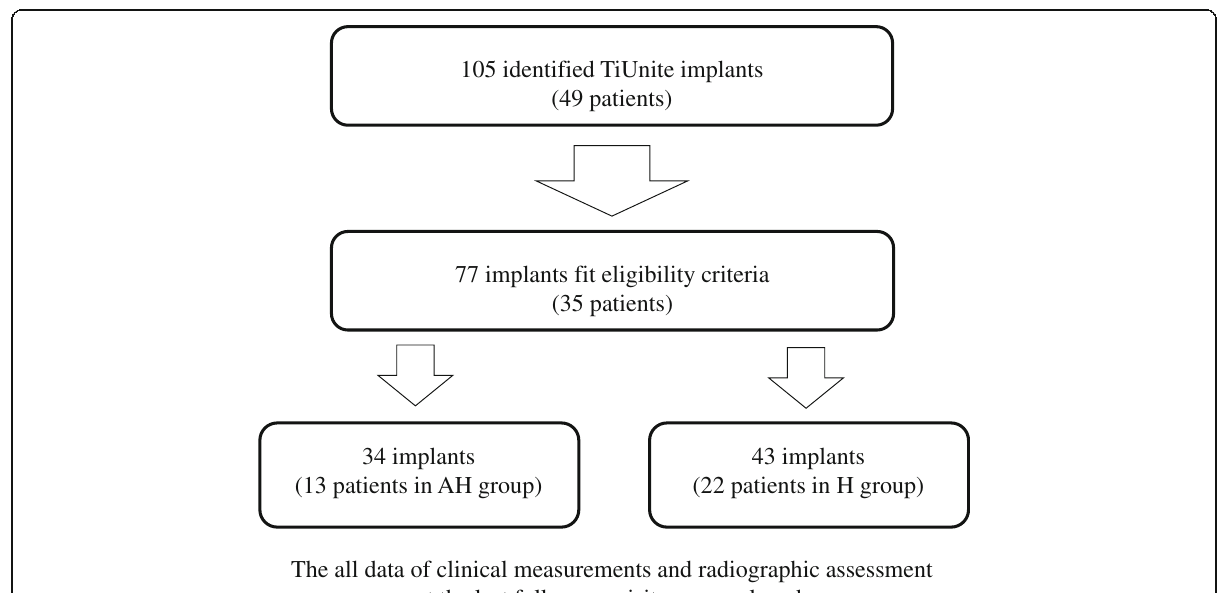
Fig. 1 The all data of clinical measurements and radiographic assessment at the last follow-up visit were